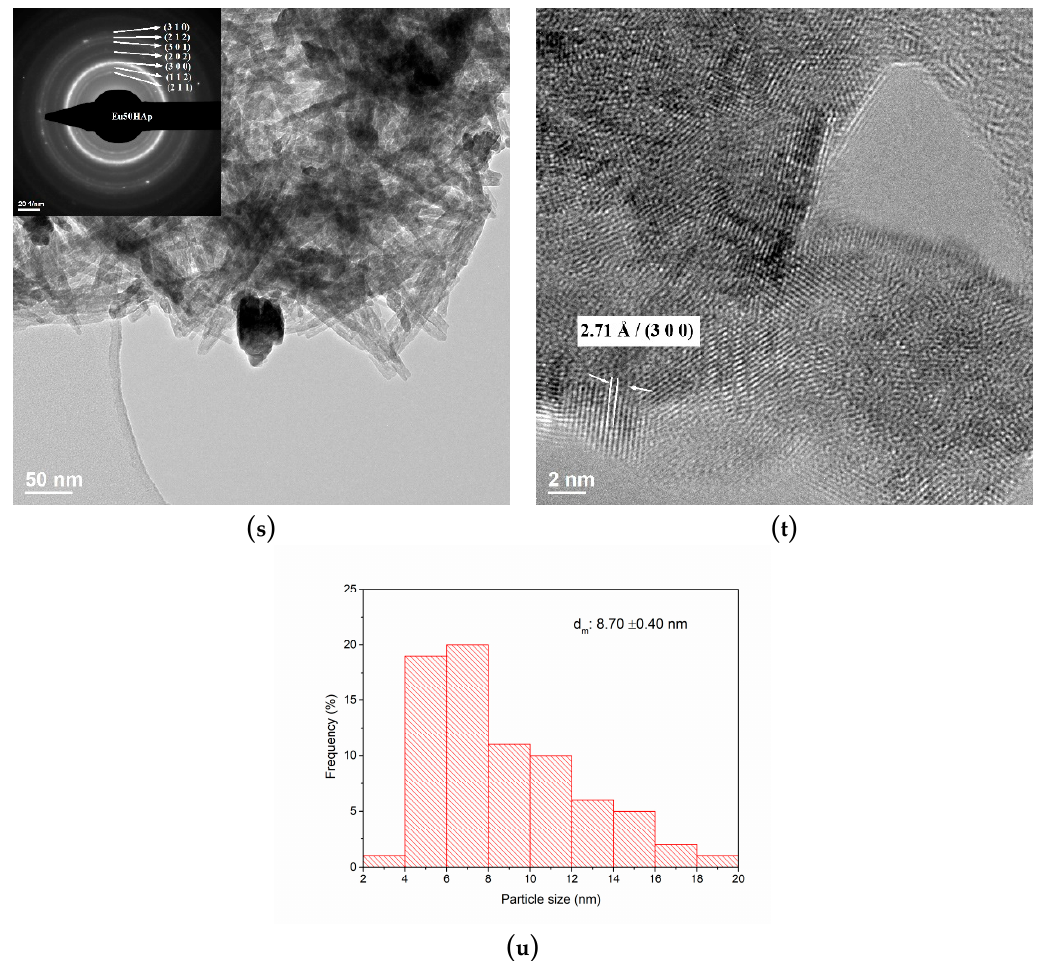
Figure 5. The TEM and HRTEM images, SAED patterns and particle size distribution of pure HAp and Eu X HAp samples ( a – c ) HAp, ( d – f ) Eu0.5HAp, ( g – i ) Eu1HAp, ( j – l ) Eu1.5HAp, ( m – o ) Eu2HAp, ( p – r ) Eu10HAp, ( s – u ) Eu50HAp.